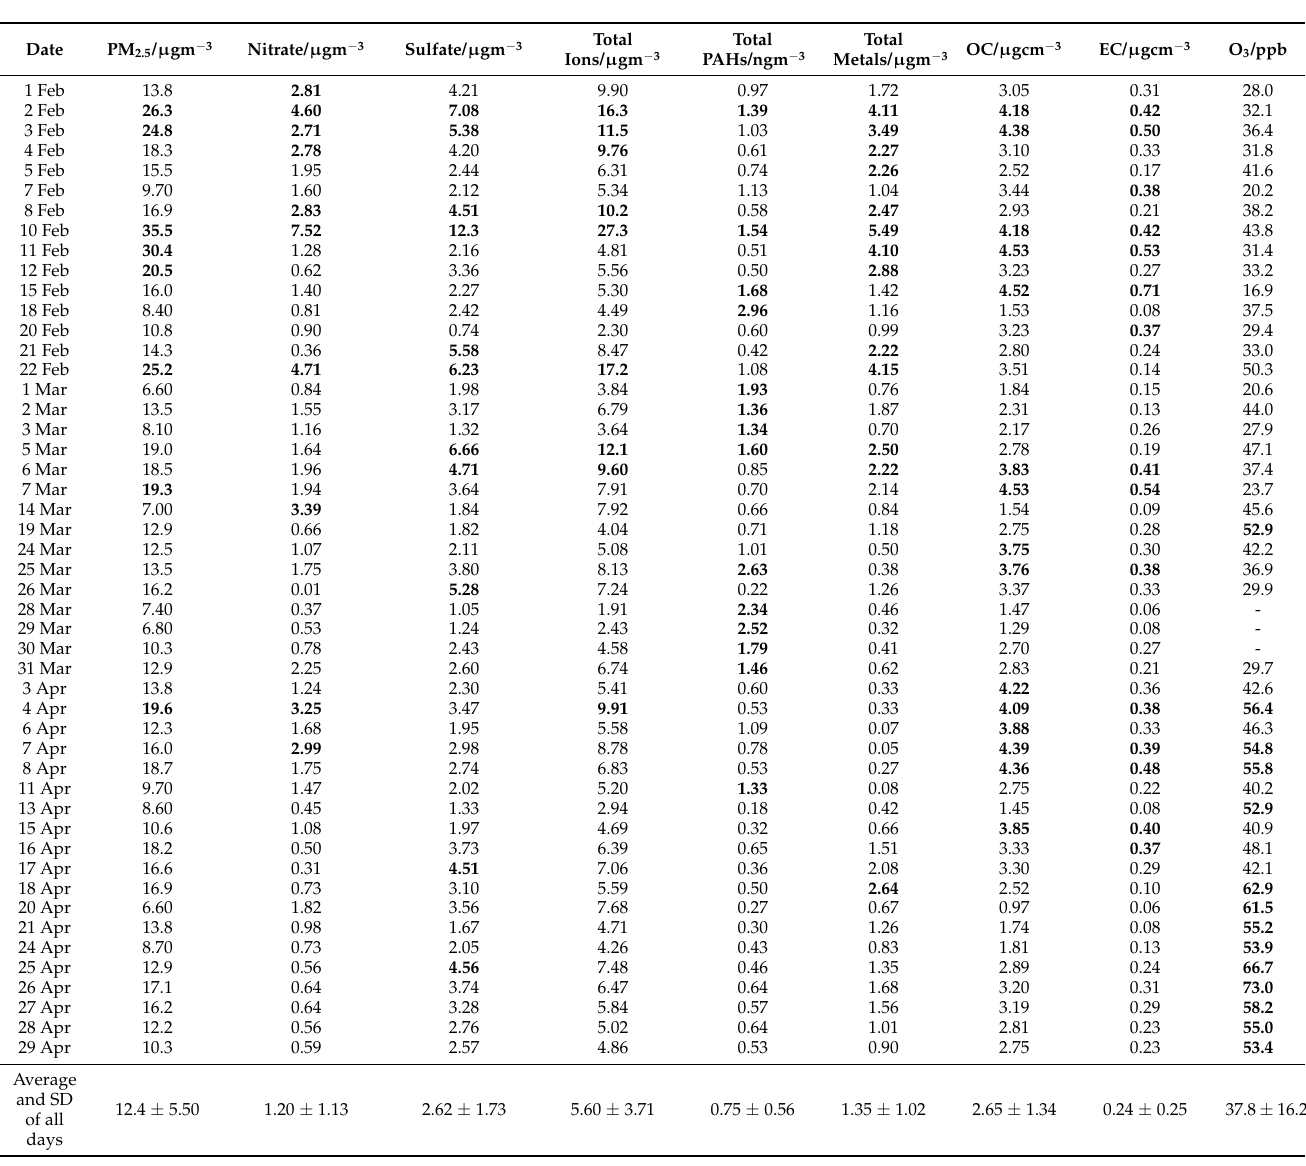
Table 1. Days of high concentration of various chemical compositions in PM 2.5 and ozone in spring 2020. High concentration data is bolded. Ozone for 28–30 March were missing. SD means standard deviation (1 σ